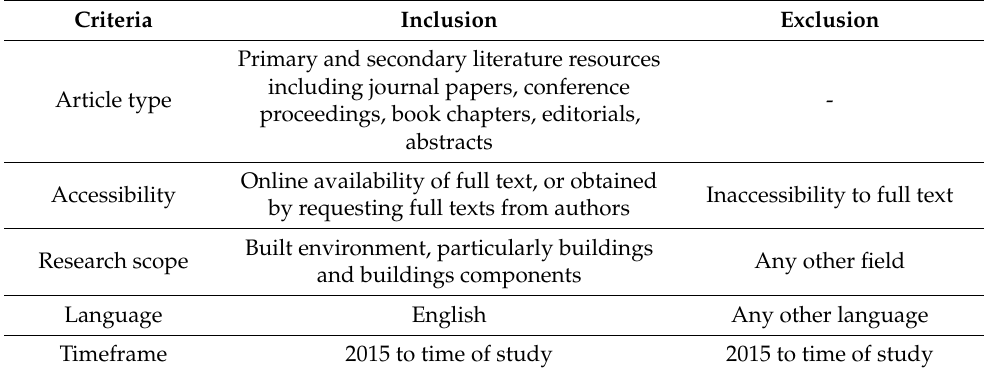
Table 3. Inclusion and exclusion criteria for obtained